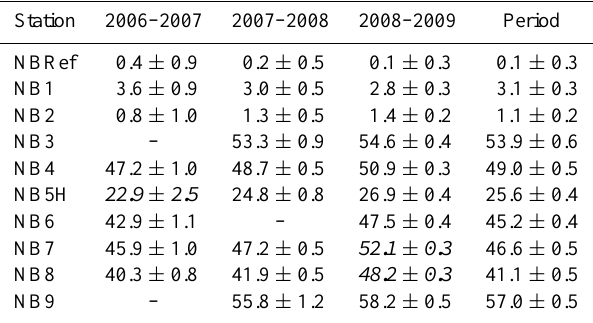
Fig. 5. Lomb periodogram of NBRef data collected between March 2006 and April 2008. The dotted line indicates the 95% significance level. Annual flow velocities of Nordenski¨oldbreen. V av (myr − 1 ) is calculated using Eq. (1), with n p = n v = 240. A ve- locity year runs from day 91 to day 90 of the following year. Pe-